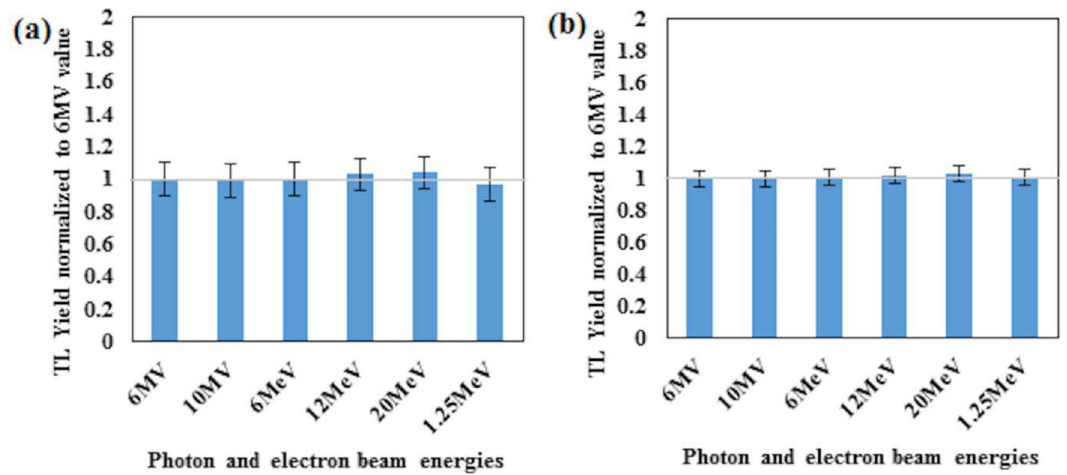
Fig 9. The dependency of energy for fibres. Energy dependency of (a) 42 μ m core sizes, and (b) PCF-collapsed is shown in the figure.